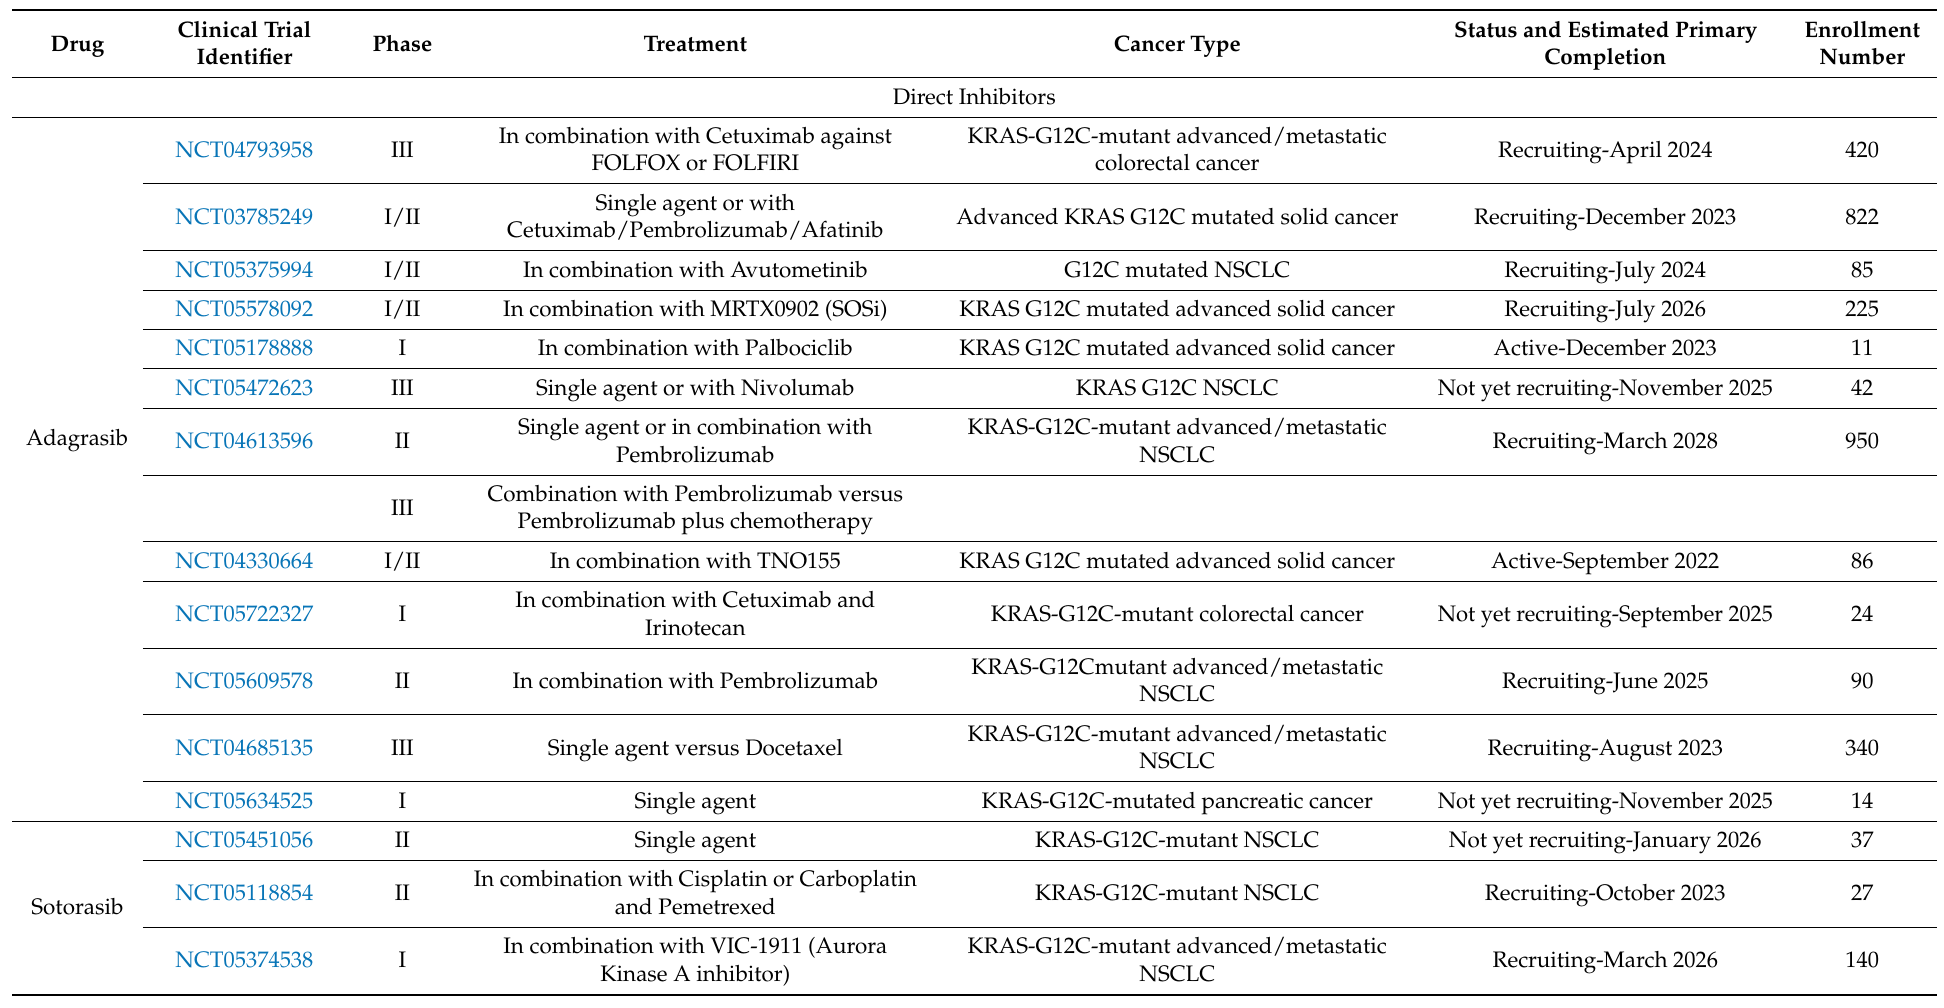
Table 2. Current clinical trials evaluating therapies of KRAS-mutant cancers with a focus on colorectal